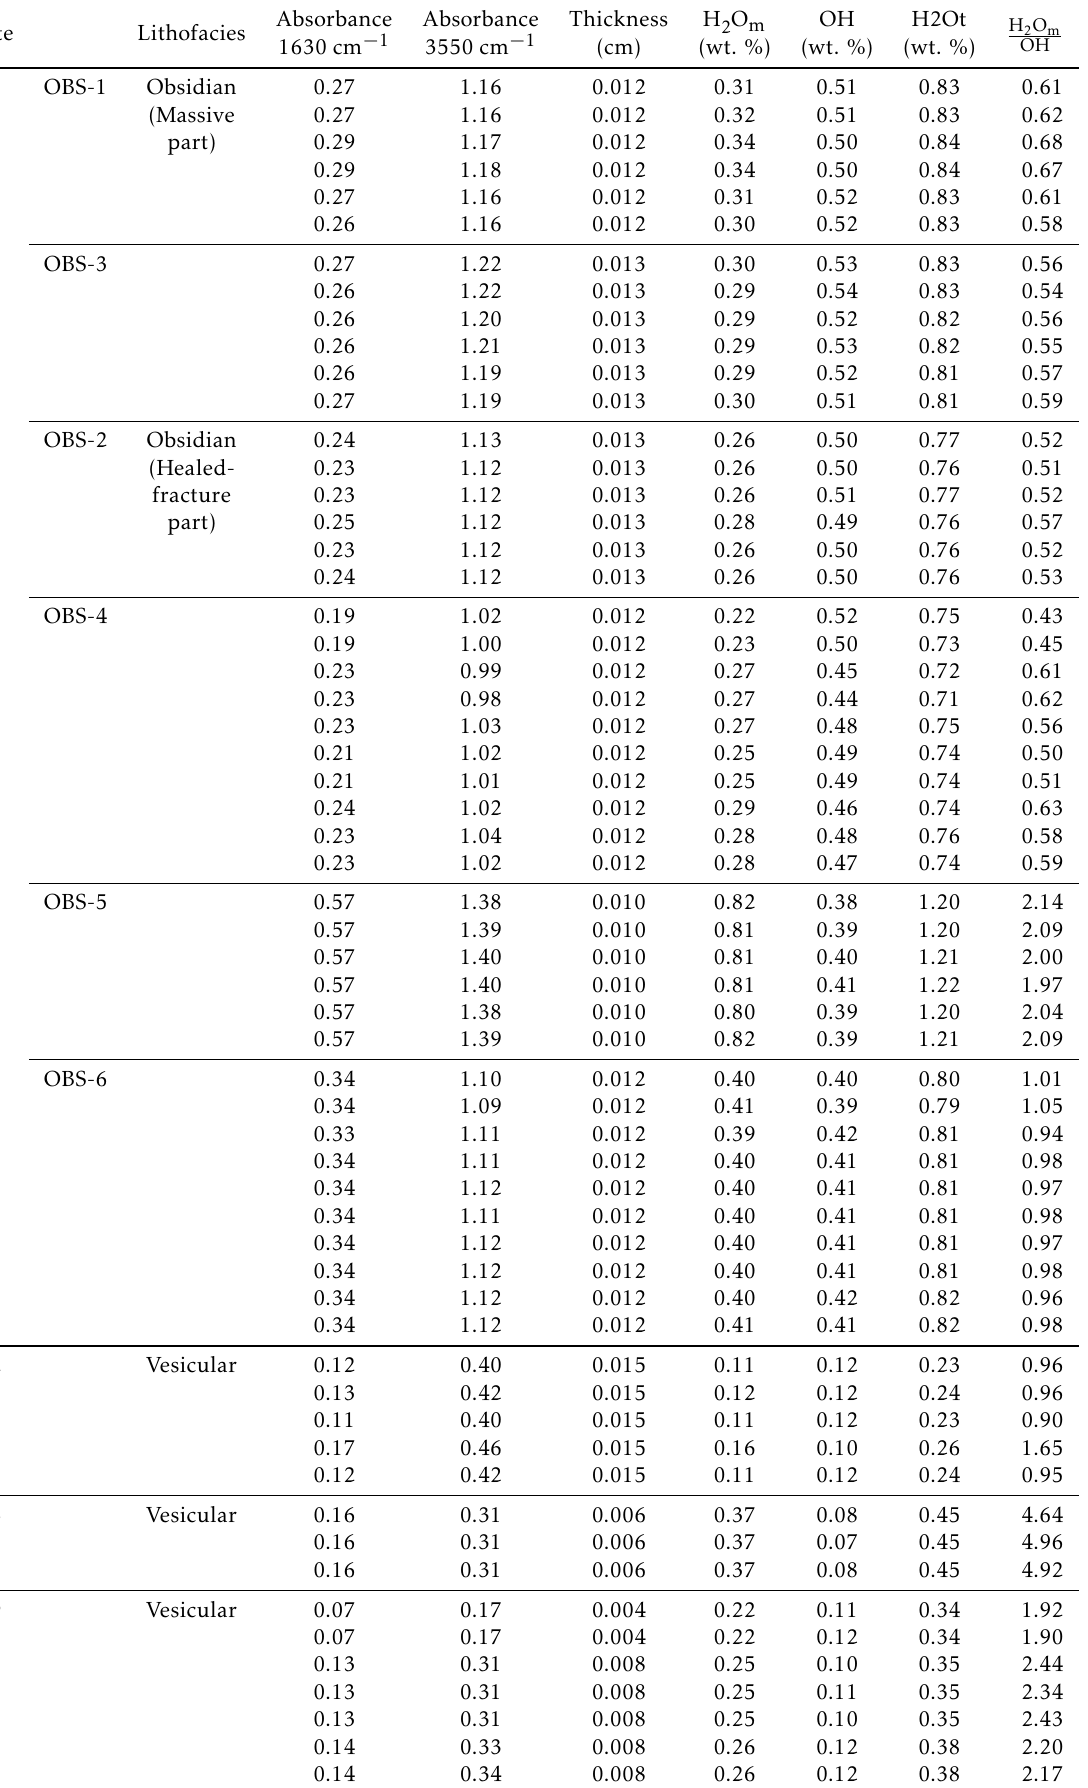
Table A2: Results of FTIR analyses of Shiroyama